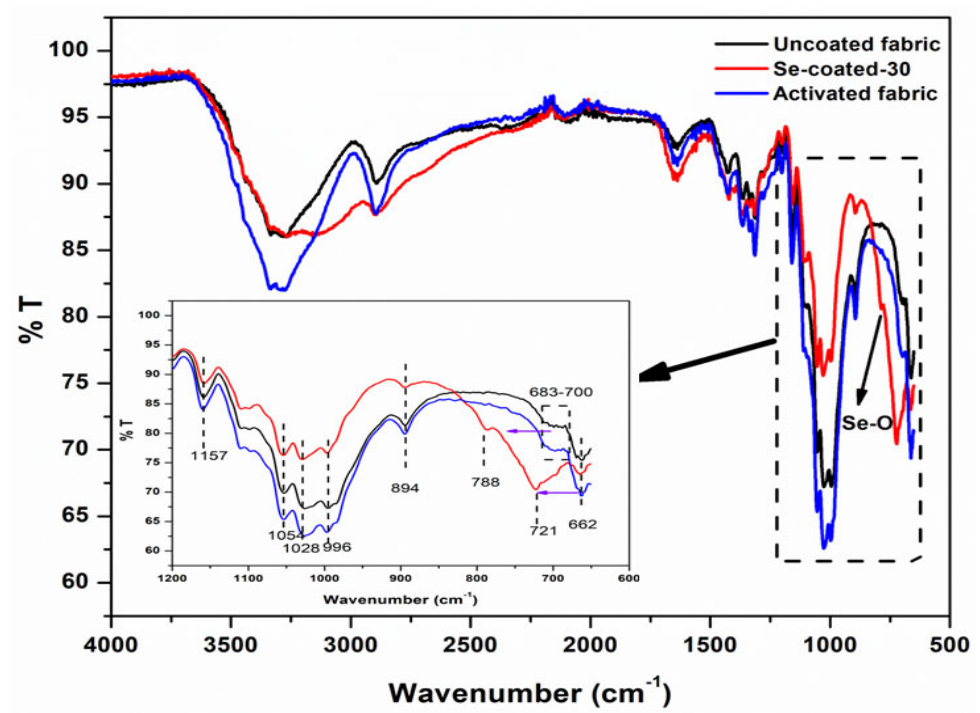
Figure 6. FTIR of Uncoated, Activated, and Se-coated fabric samples. Inset shows region between